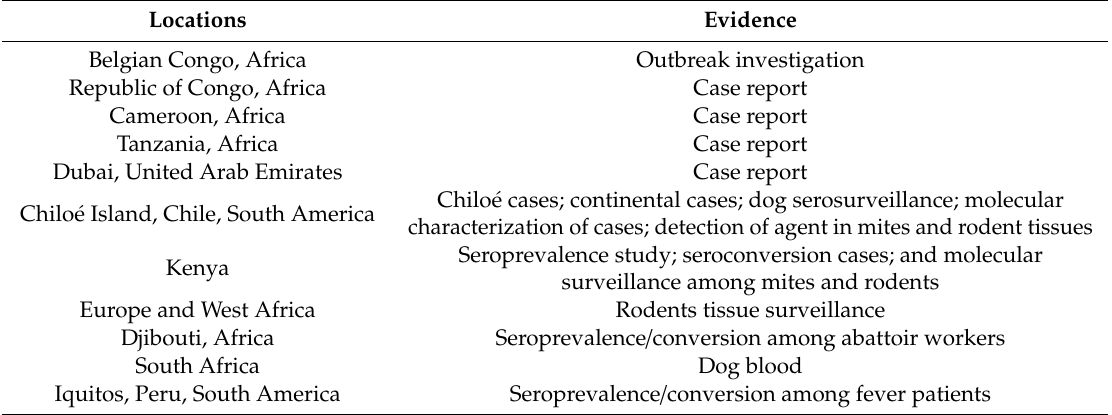
Table 4. Evidence of Scrub Typhus Outside of the Tsutsugamushi